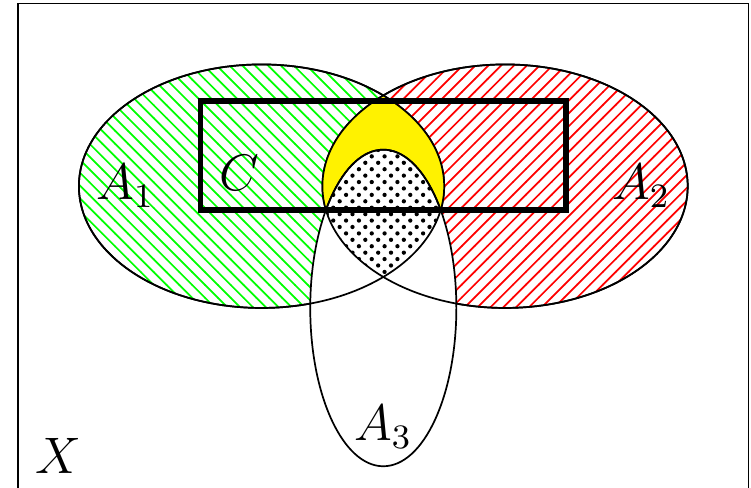
Figure 1. A Venn